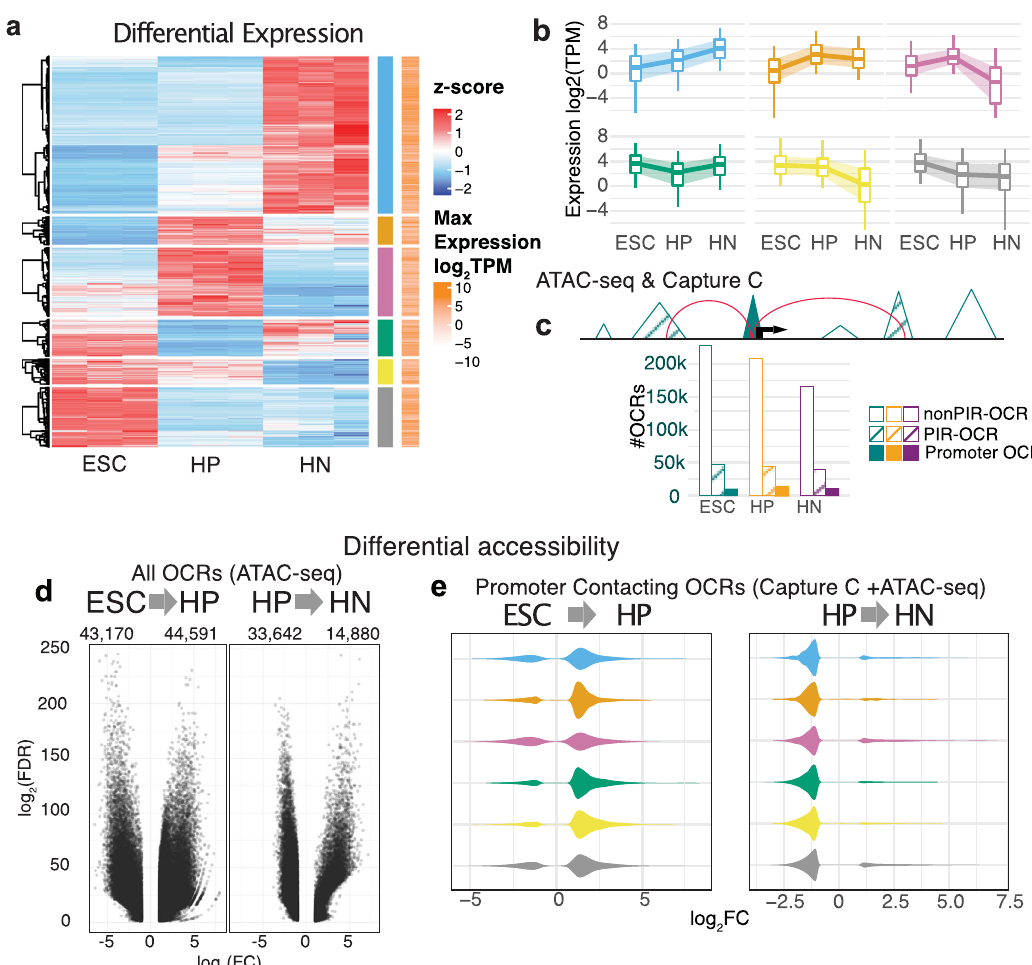
Fig. 2 Changes in gene expression and chromatin architecture underlying hypothalamic neuron differentiation. a Heatmap of the scaled expression values ( z -score) of each RNA-seq sample of ESC, HP, and HN for the 15,808 genes with differential expression in at least one stage of differentiation. Red indicates higher relative expression, while blue indicates lower relative expression. From hierarchical clustering, the genes were assigned to six groups based on their expression pattern pointed to being either speci fi cally enriched or depleted in one condition (blue, orange, pink, green, yellow, gray bars). The log-transformed condition-wise max TPM value for each gene is plotted where white indicates lower expression and orange indicates higher expression compared to other genes. b The global average of expression values (TPM) of the genes in each cluster. The central line of each boxplot represents the median, with edges representing the 25 and 75 percentiles, and whiskers represent the 5 and 95 percentiles. c Sets of OCRs were assigned based on location: promoter OCRs (solid), PIR-OCRs (hashed), and non-PIR-OCRs the remaining OCRs that were not annotated to a gene (promoter OCR- ESCs: 9796, HPs: 12,962, HNs: 10,241; PIR-OCR- ESCs: 46,968, HPs: 43,860, HNs: 39,942; non-PIR-OCR ESC: 228,747, HP: 208,763, HN: 165,860). Bottom: the distribution of number OCRs annotated to each set per cell type. d Volcano plot depicting the global genome-wide signi fi cant differentially accessible OCRs in the transition from ESC to HP (left) and HP to HN (right). e Distribution of chromatin accessibility fold change of cRE annotated to DE gene clusters ( a